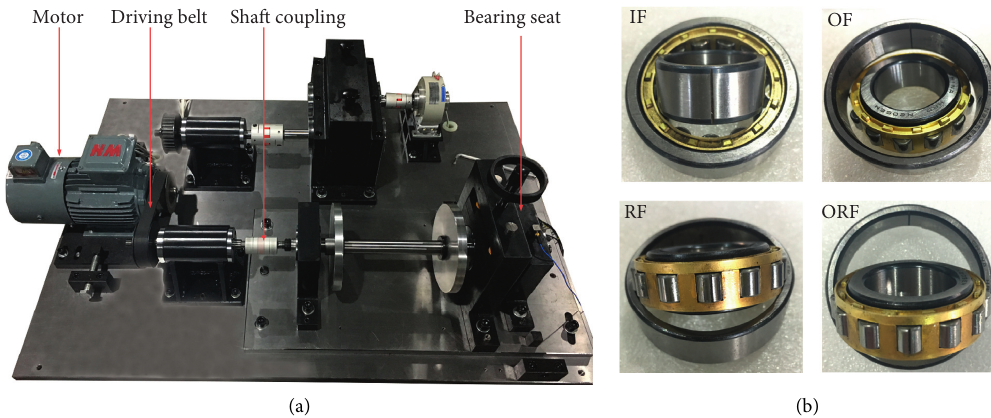
Figure 3: (a) Test rig of bearing fault. (b) Four fault